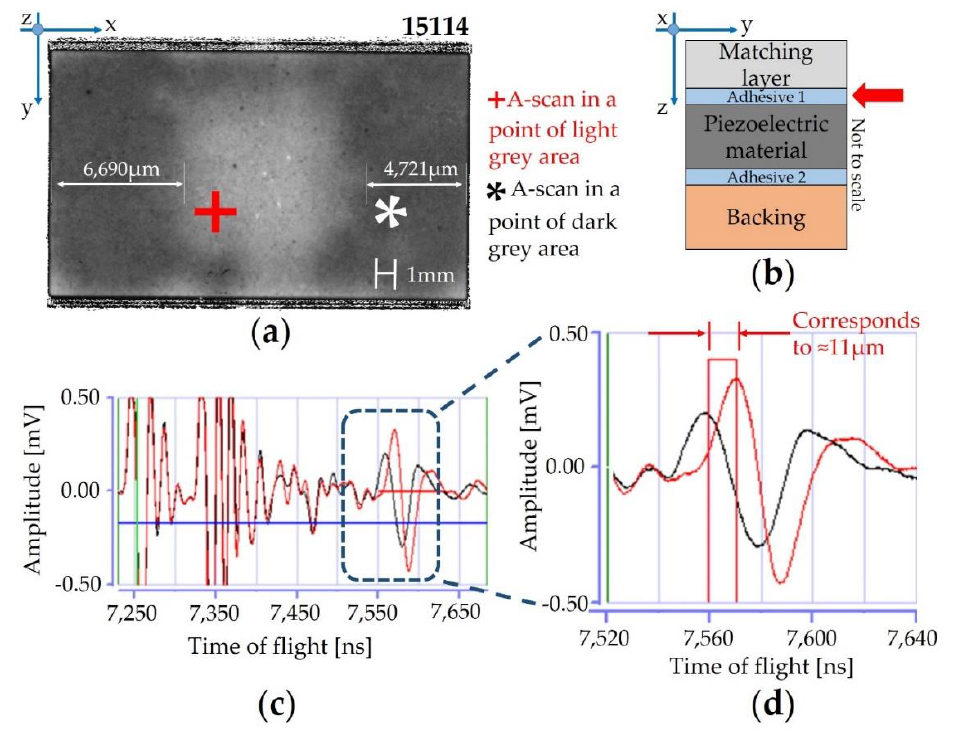
Figure 11. SAM characterization of the sample 15,114 – lot #1: ( a ) the two different points with different bonding lines; ( b ) layer under detection; ( c ) A-scans diagram; ( d ) zoom of the A-scans for the adhesive layer 1.